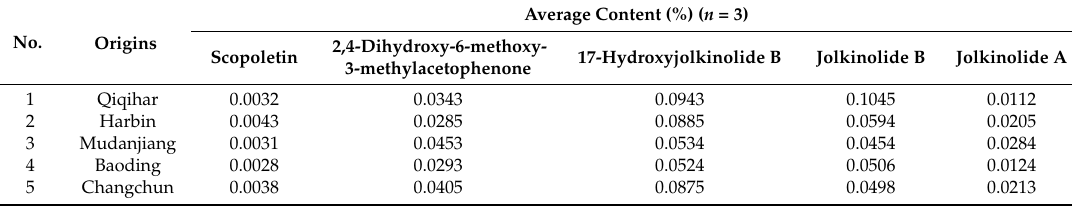
Table 5. Contents of Scopoletin, 2,4-Dihydroxy-6-methoxy-3-methylacetophenone, 17-Hydroxyjolkinolide B, Jolkinolide B, and Jolkinolide A of Euphorbia fischeriana samples produced in Qiqihar, Harbin, Mudanjiang, Baoding, and Changchun ( n =